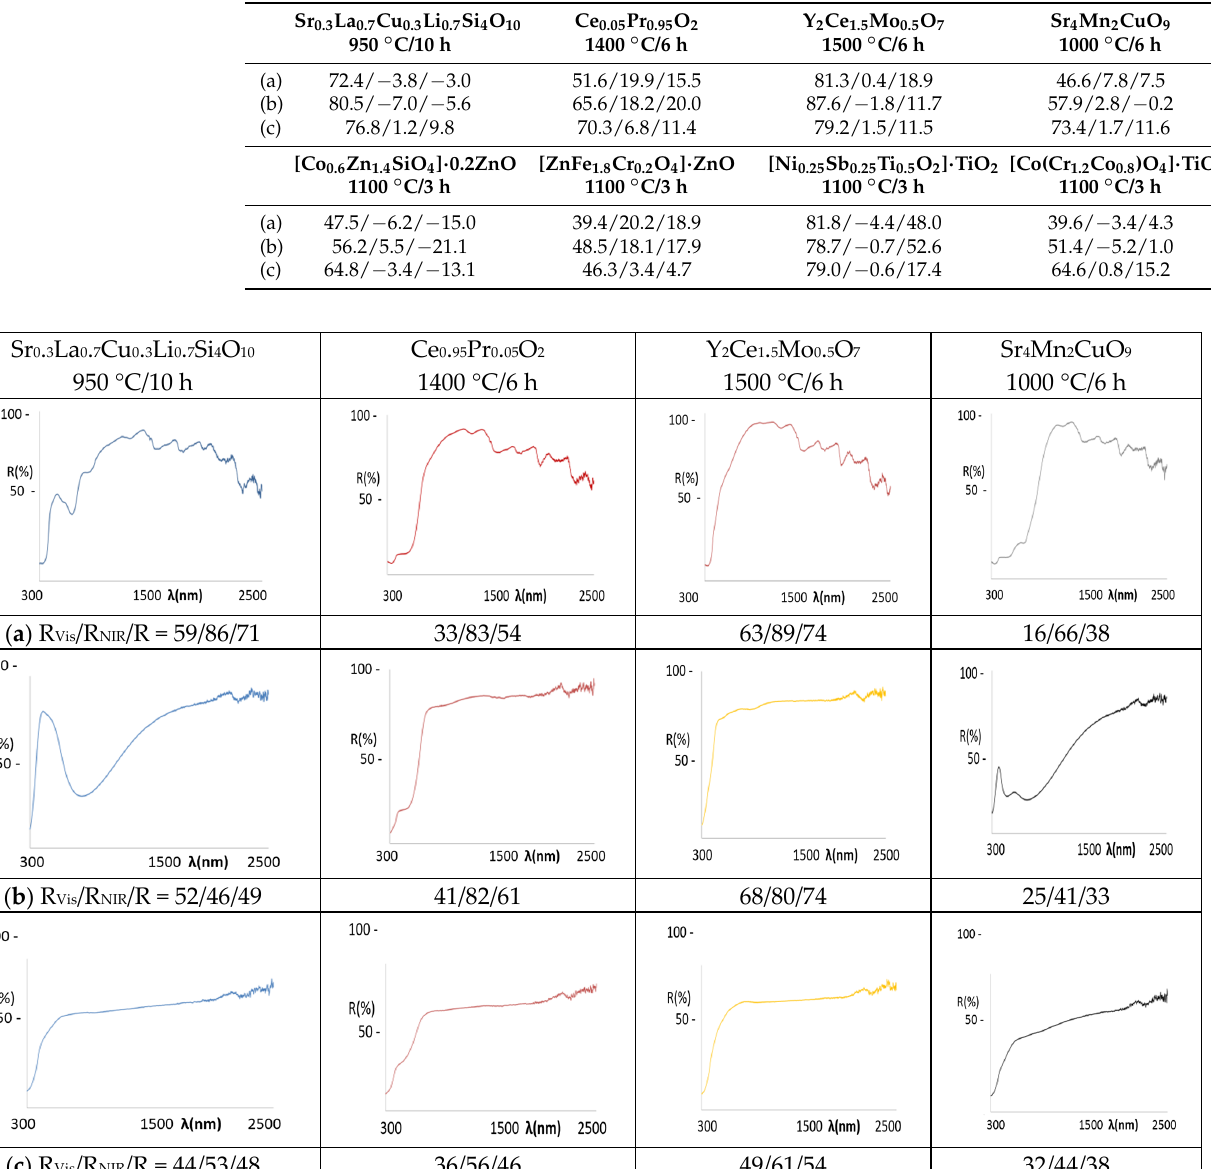
Table 6. L*a*b* values for the applications of pigments: (a) 10 wt.% in colourless alkyd paint, (b) 3 wt.% in double firing frit (1050 ◦ C), (c) 2% wt.% in porcelain stoneware (1190 ◦ C).